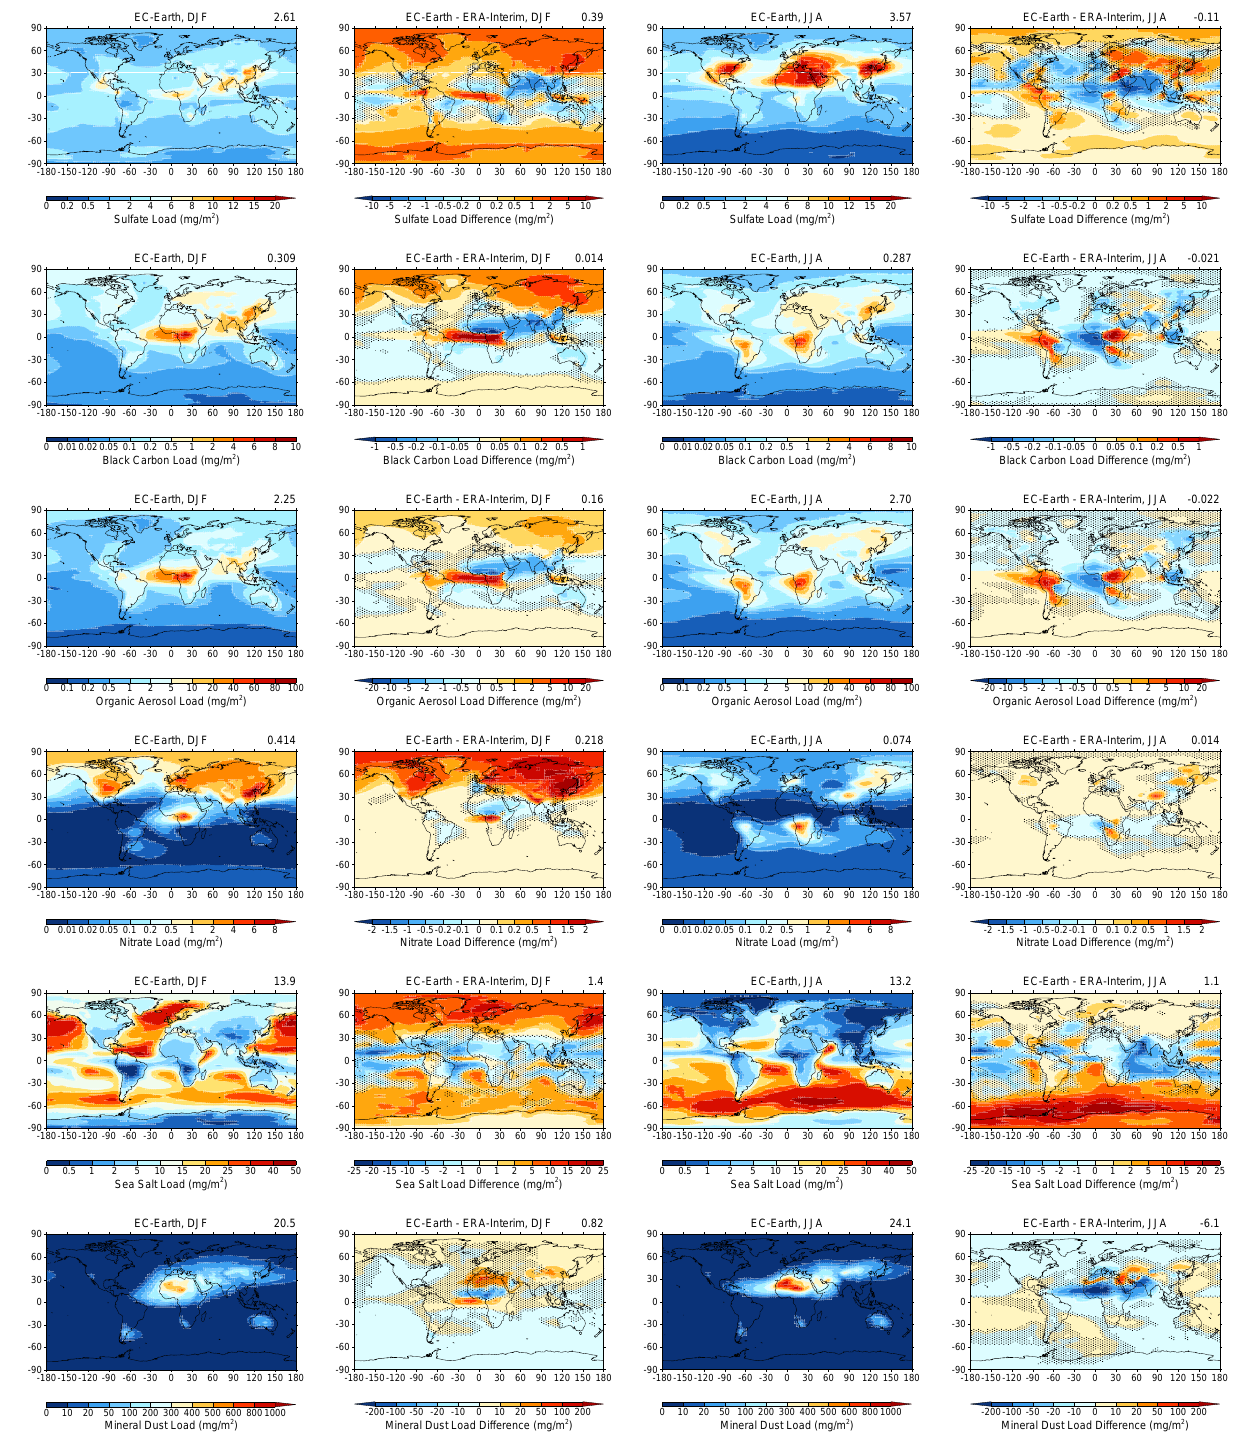
Figure 12. Total loads of the different aerosol components in the reference EC-Earth simulation and the differences compared to the corre- sponding ERA-Interim simulation for boreal winter (left two columns) and boreal summer (right two columns). The global mean values of the displayed fields are indicated at the top of each